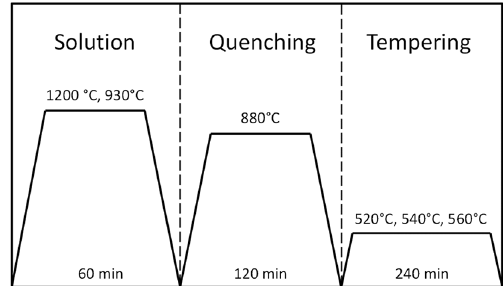
Figure 3. Heat treatment